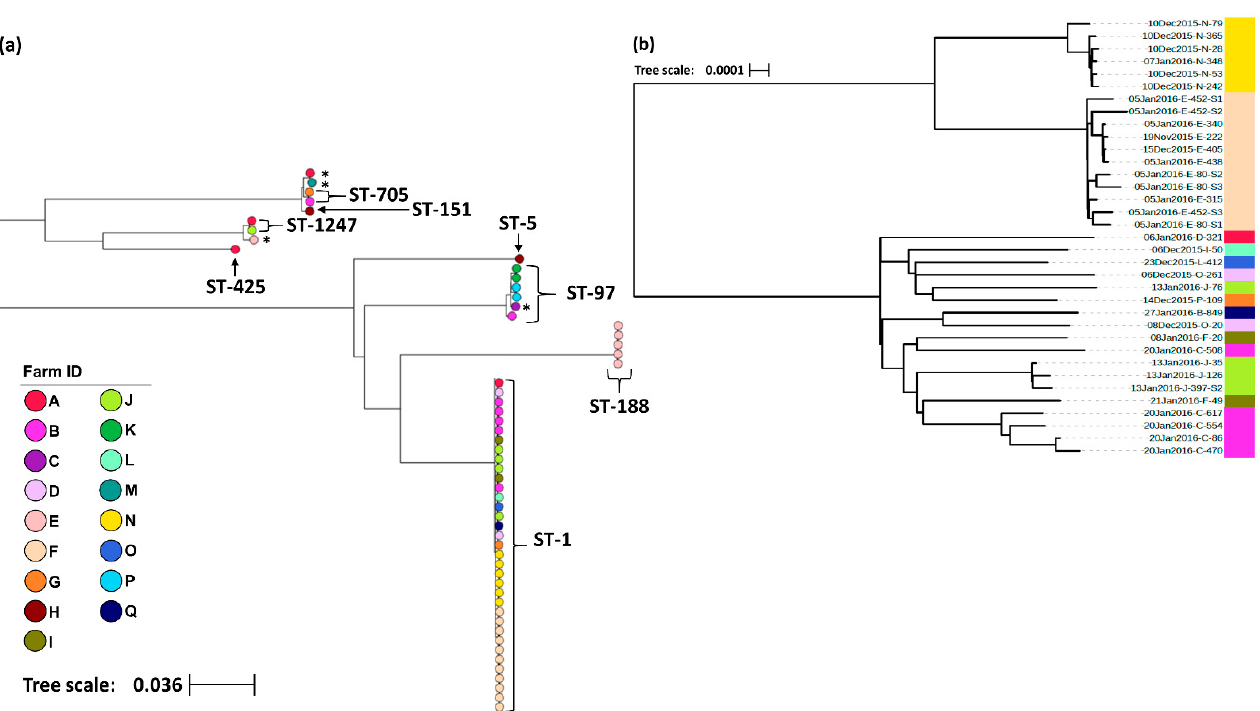
Bold: the bold headings are to clarify at what level prevalence has been calculated as described in the table heading.